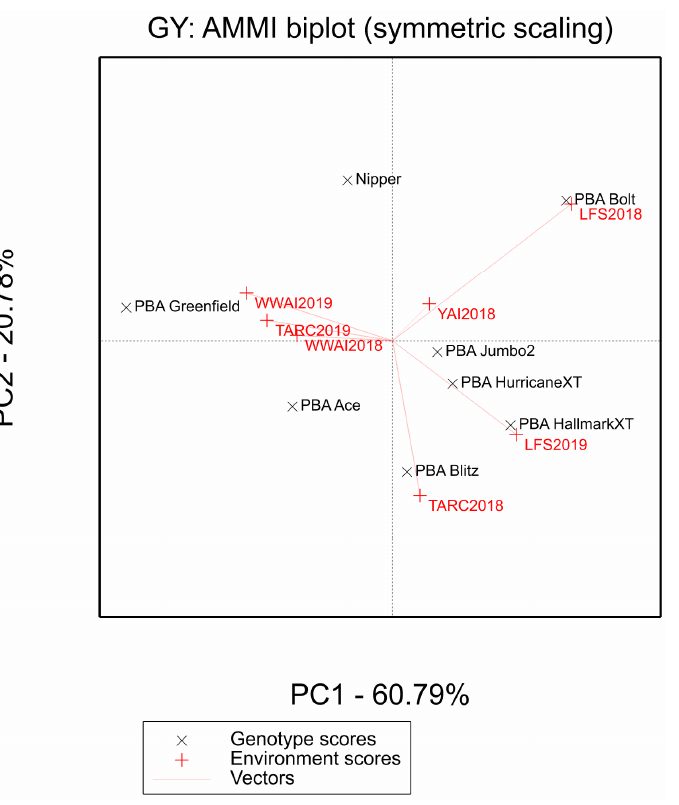
Figure 2. AAMI biplot for grain yield showing the correlation between environments and overall genotype stability and adaptability. At origin GEI = 0. Acute angle = positive correlation; right angle = no correlation and obtuse angle = negative correlation. TARC18 = Trangie Agricultural Research Centre 2018 experiment; TARC19 = Trangie Agricultural Research Centre 2019 experi- ment; WWAI18 = Wagga Wagga Agricultural Institute 2018 experiment; WWAI19 = Wagga Wagga Agri cultural Institute 2019 experiment; LFS18 = Leeton Field Station 2018 experiment; LFS19 = Leeton Field Station 2019 experiment; and YAI18 = Yanco Agricultural Institute 2018 experiment.